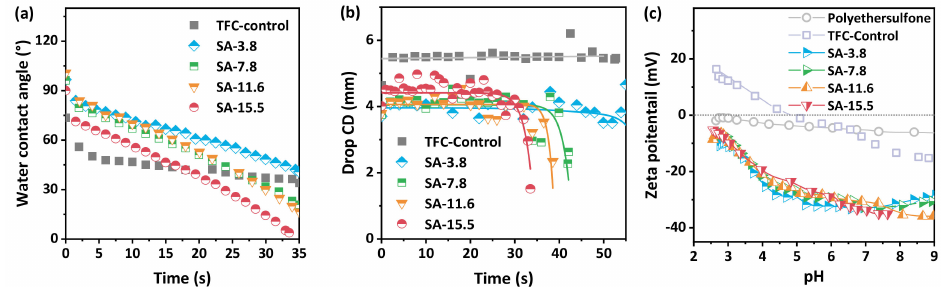
Figure 5. Surface properties of the SA–TFC membranes: ( a ) Dynamic water contact angle of TFC − Control and SA–TFC membranes; ( b ) Dynamic drop CD of TFC − Control and SA–TFC mem- branes; ( c ) Zeta potential of the porous substrate, TFC − Control, and SA–TFC